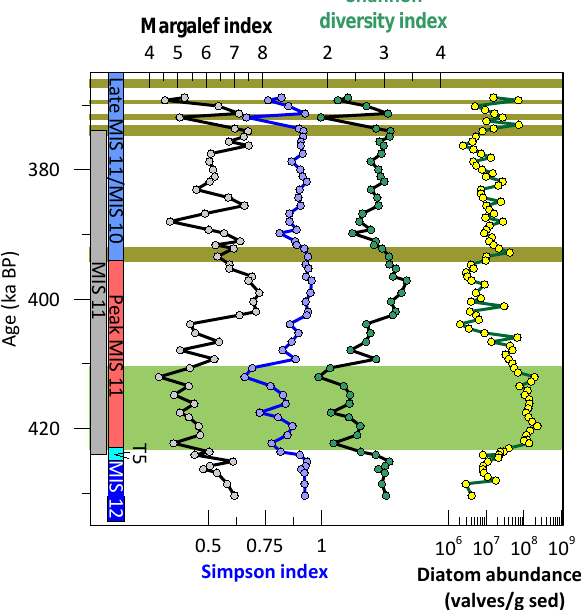
Figure 5. The Margalef, Simpson, and Shannon diversity indices plotted with diatom abundances. Type I laminations are depicted as pale-green bars and type II laminations are depicted as olive-green bars. Colored vertical bars refer to the zones mentioned in the